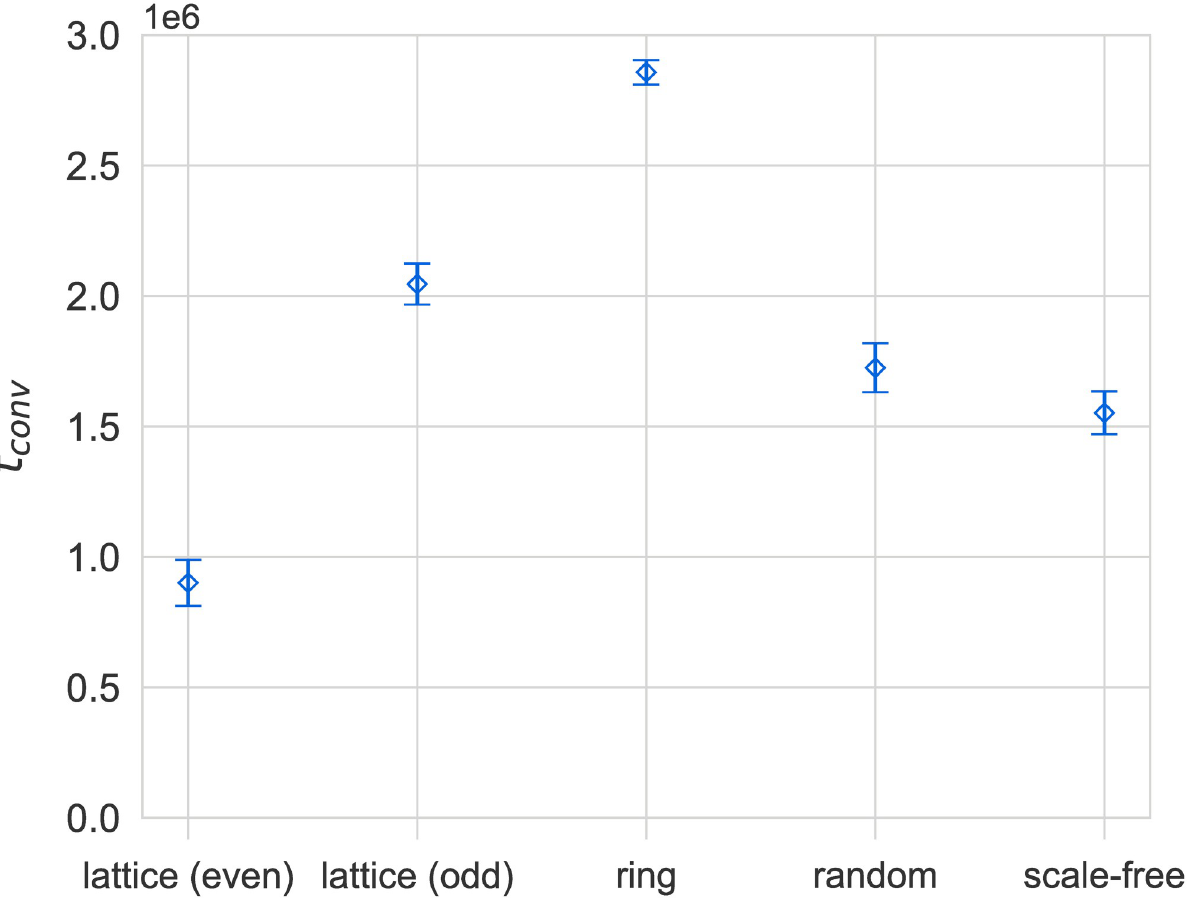
Fig 3. Differences in mean convergence time to a common language t on different network topologies (left, plot) and average shortest path conv length L for all networks (right, table). Convergence times are roughly correlated with average shortest path lengths, with the exception of even-sized lattices. Results are for N = 500 and bars indicate standard